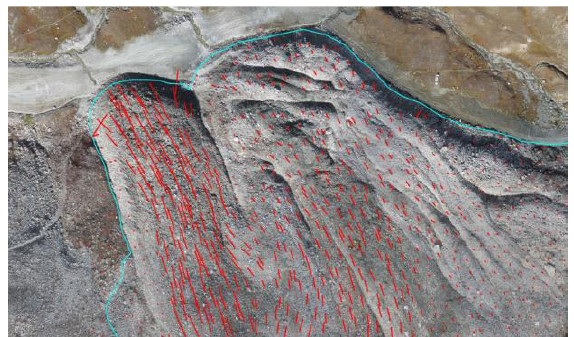
Figure 4: Displacements vectors (red line magnification x4) calculated manually on 746 tie points on the orthoimages.